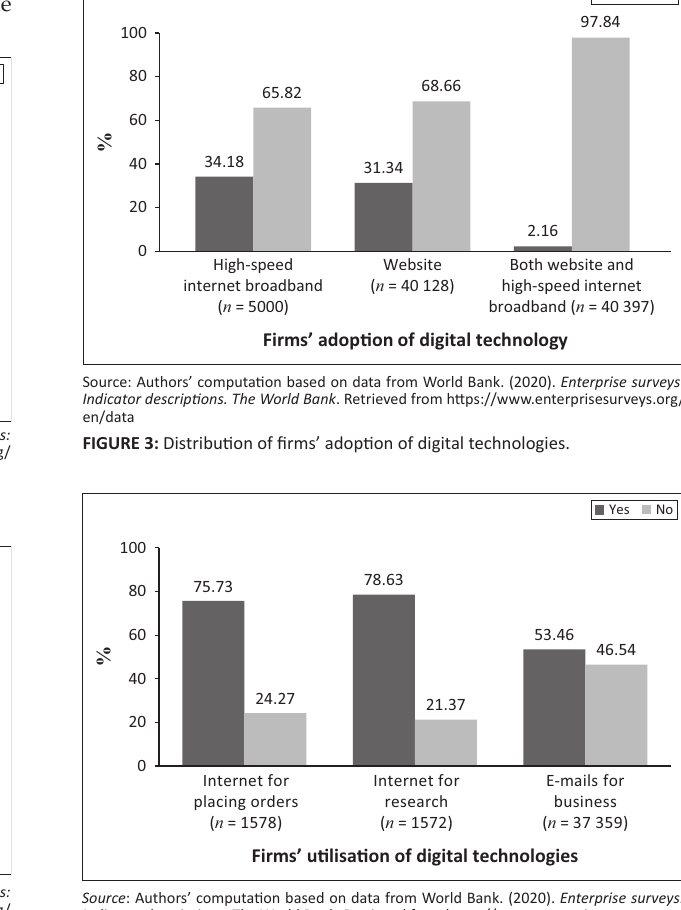
en/data FIGURE 4: Firms’ utilisation of digital technologies for business activities.